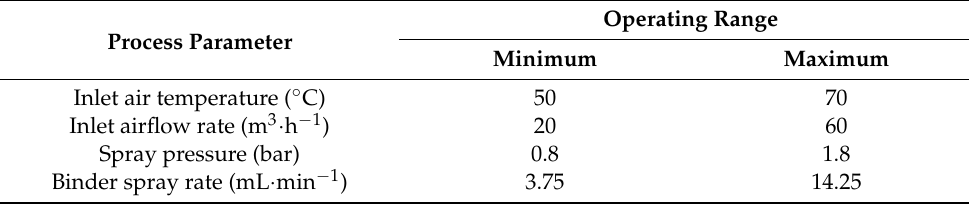
Table 1. Operating ranges of the process